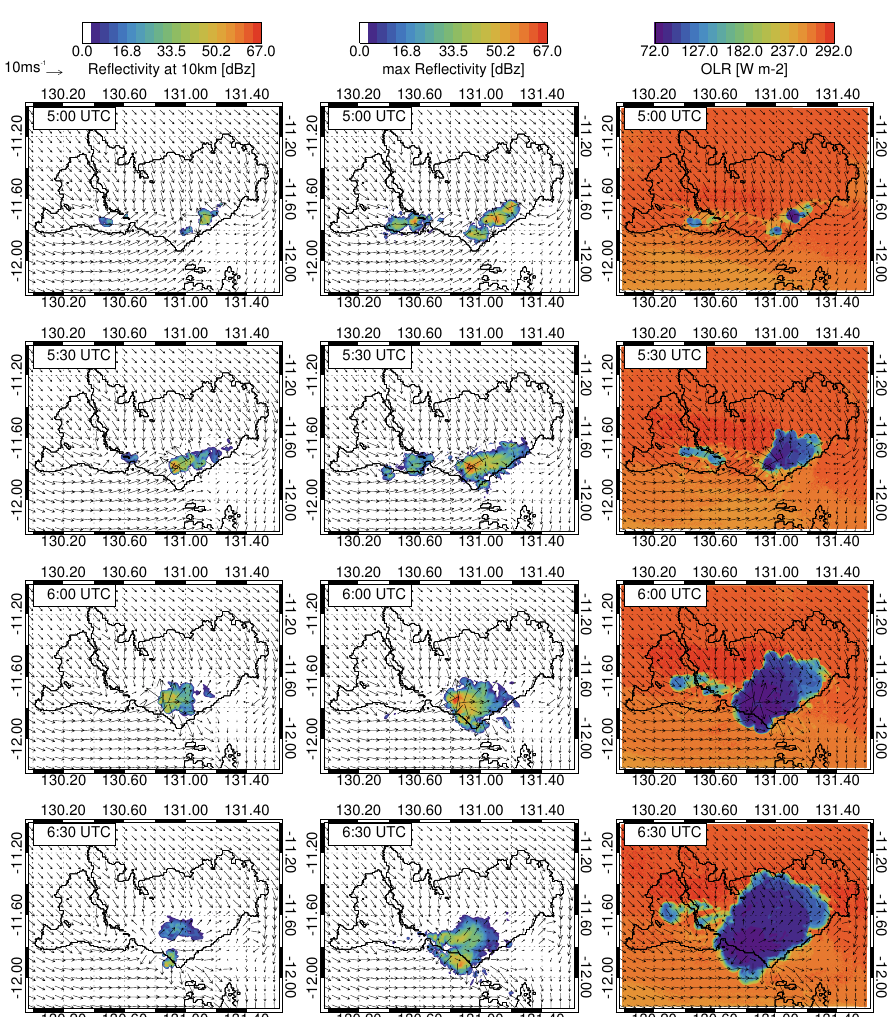
Figure 4. Evolution of 10m surface winds (arrows), radar reflectivity at 10km altitude (left panels), column maximum reflectivity (middle panels), and OLR (right panels) as simulated in domain 5.